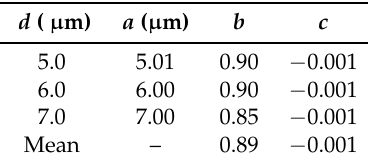
Table 1. Facing electrode chip. Parameters of quadratic model equation D = a [ 1 + b ( ∆ − c ) 2 ] fitted to data plotted in Figure